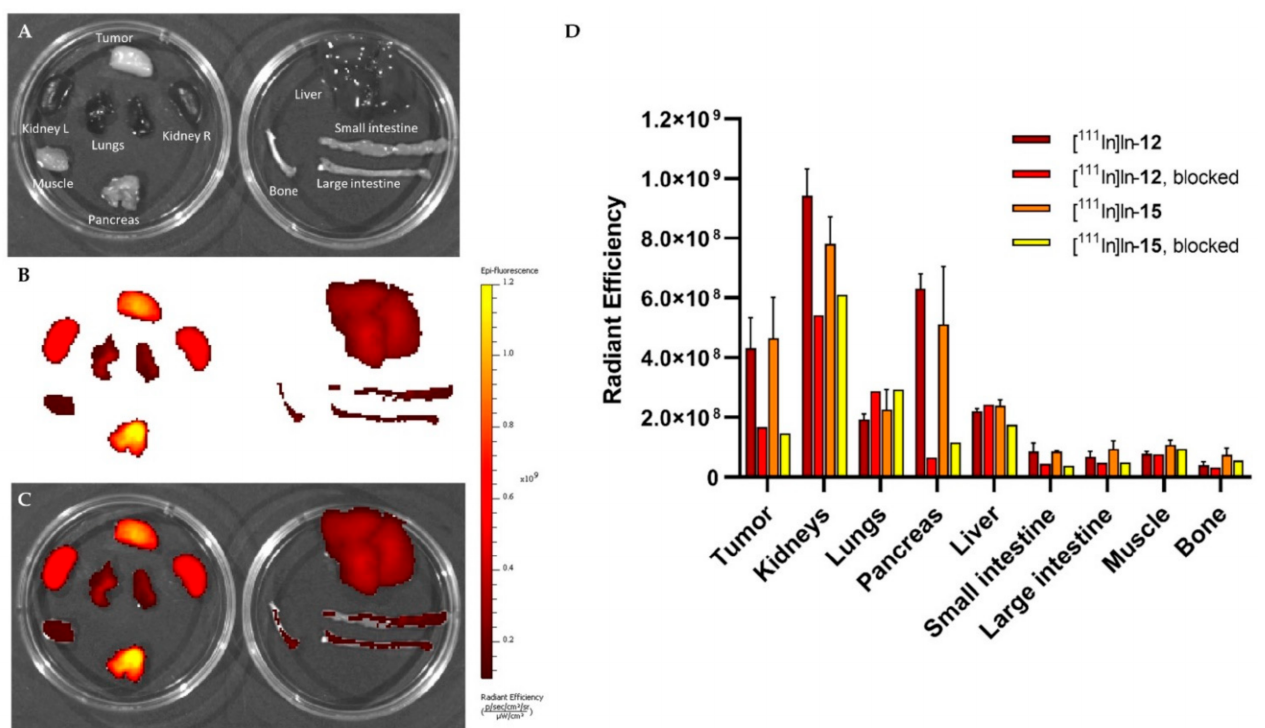
Figure 4. Ex vivo fluorescence imaging of a subset of organs. A representative example of ( A ) a photograph (organ tags in white), ( B ) a fluorescence image, and ( C ) their overlay, obtained with IVIS imaging of [ 111 In]In- 15 in PC-3-xenografted Balb/c nu/nu mice after dissection. The scale bar shows the fluorescent signal intensities in radiant efficiency {(p/sec/cm 2 /sr)/( µ W/cm 2 )}. ( D ) Quantified ex vivo radiant efficiencies of [ 111 In]In- 12 and [ 111 In]In- 15 uptake in tumor and organs (non-blocked ( n = 3); blocked ( n = 1)). Values for the unblocked group are presented as an average value ±